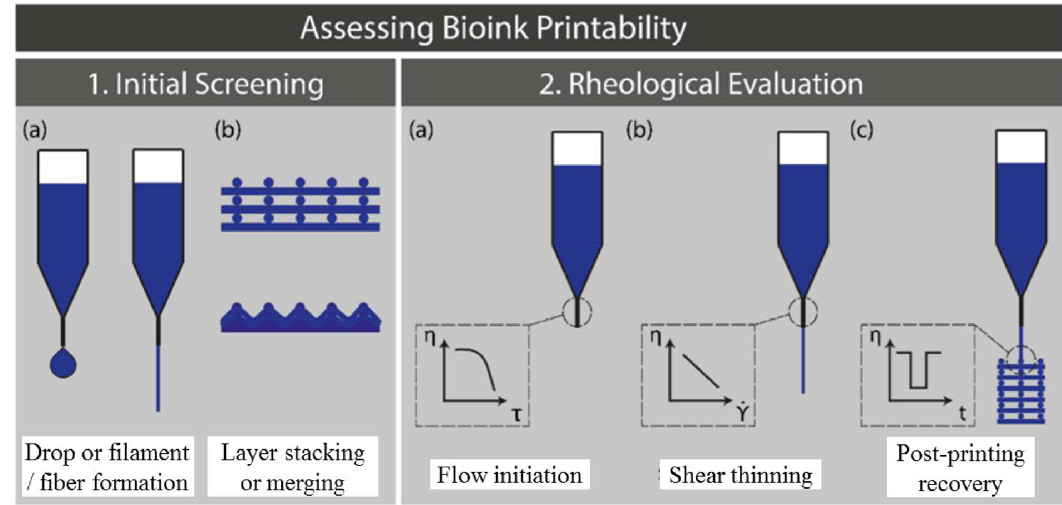
Figure 1. Schematic illustration of the workflow to assess the bioink printability for extrusion-based bioprinting [96] .